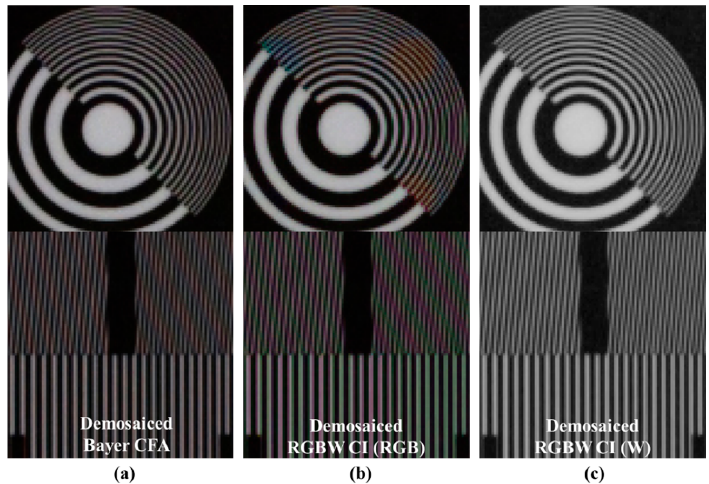
Figure 3. Comparison of Bayer demosaicing and RGBW demosaicing results: ( a ) Bayer CFA demosaicing result [19]; ( b ) red-green-blue (RGB) channels of Sony RGBW CFA demosaicing result [24]; ( c ) W channel of Sony RGBW CFA demosaicing result [24].